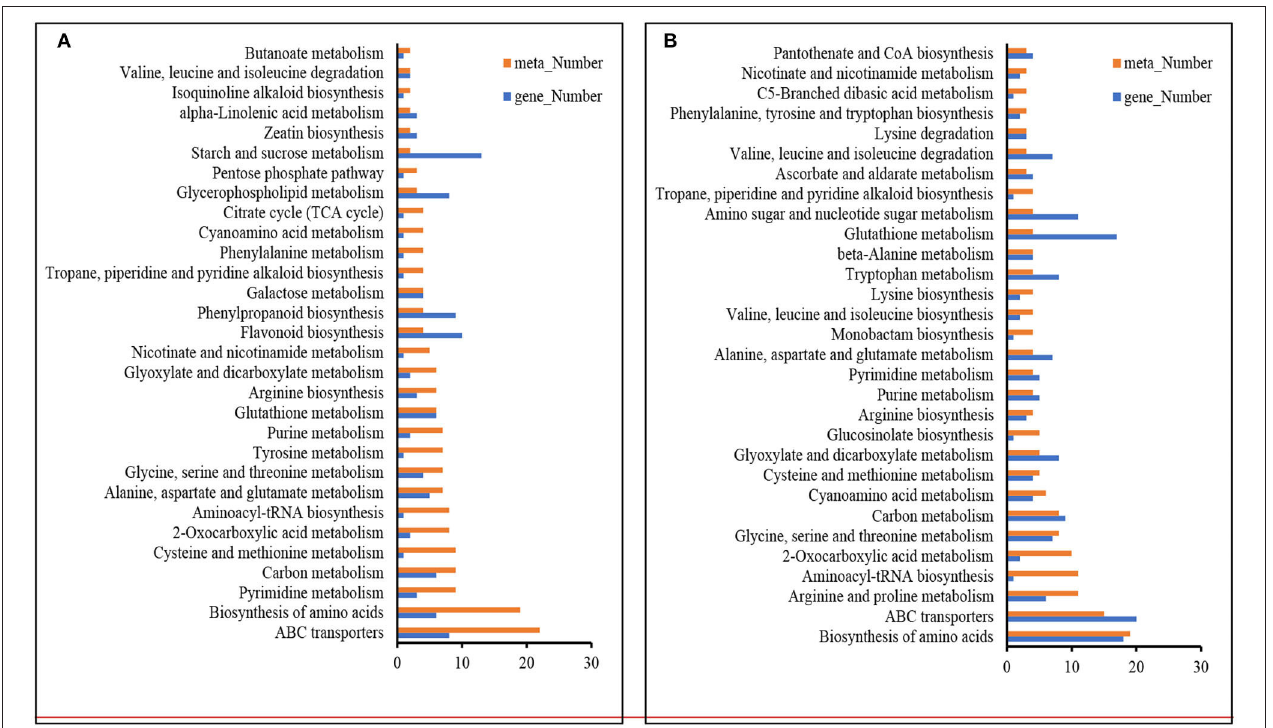
FIGURE 4 | KEGG analysis of DAMs and DEGs under K + deficiency treatment in DH605 (A) and Z58 (B) ( p ≤